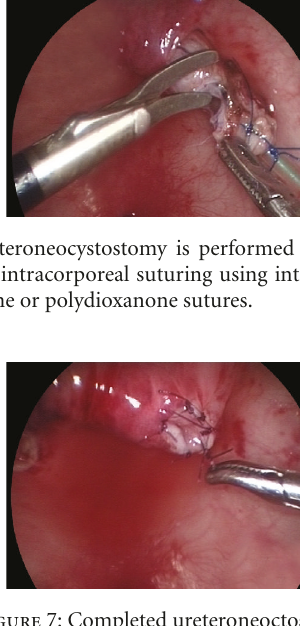
Figure 7: Completed